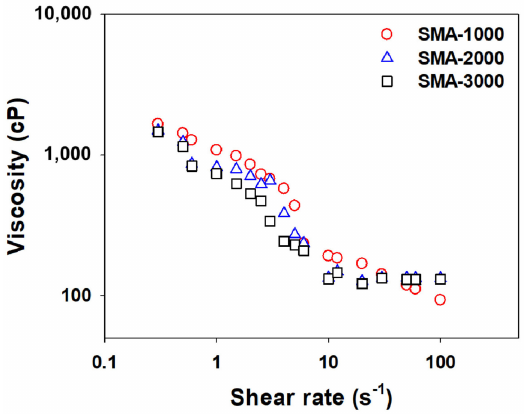
Figure 8. Variation of viscosity with shear rate measured for the CB dispersions prepared with SMA − 1000 ( ), SMA − 2000 ( (cid:52) ), and SMA − 3000 ( (cid:3) ), (cid:35)